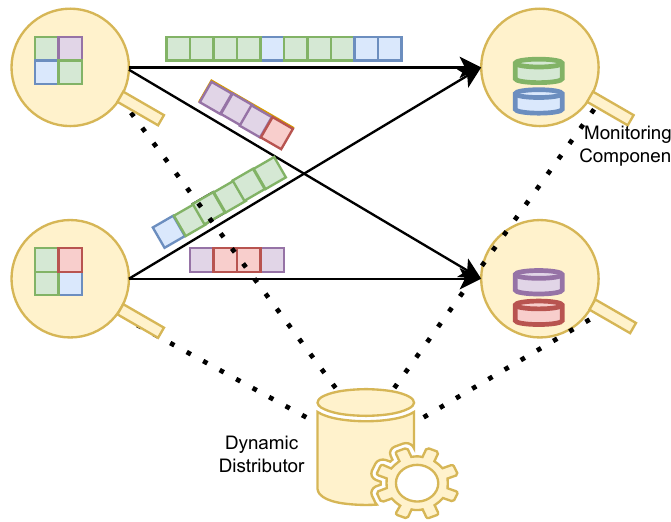
Figure 1. Logical architecture of dynamic load balancing